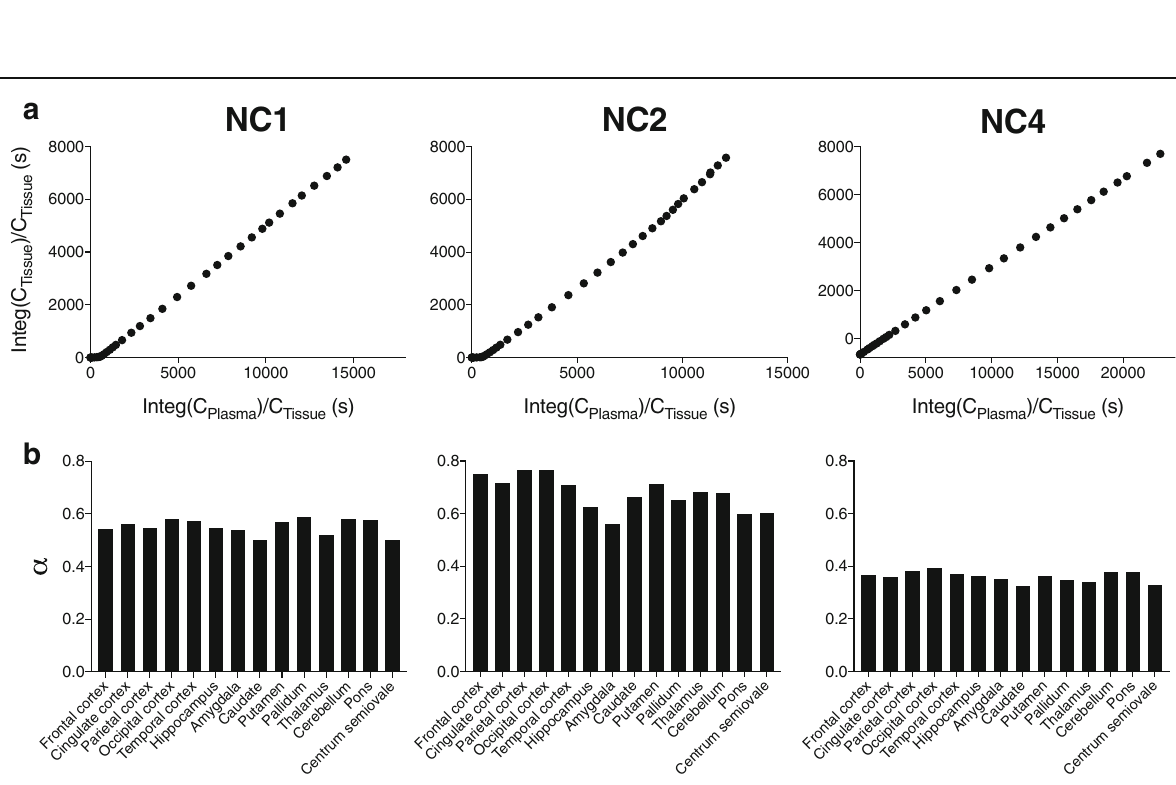
Fig. 5 a Dual-input graphical plots in the frontal cortex in three subjects. b Regional distribution volumes ( α ) determined by the dual-input graphical model in three